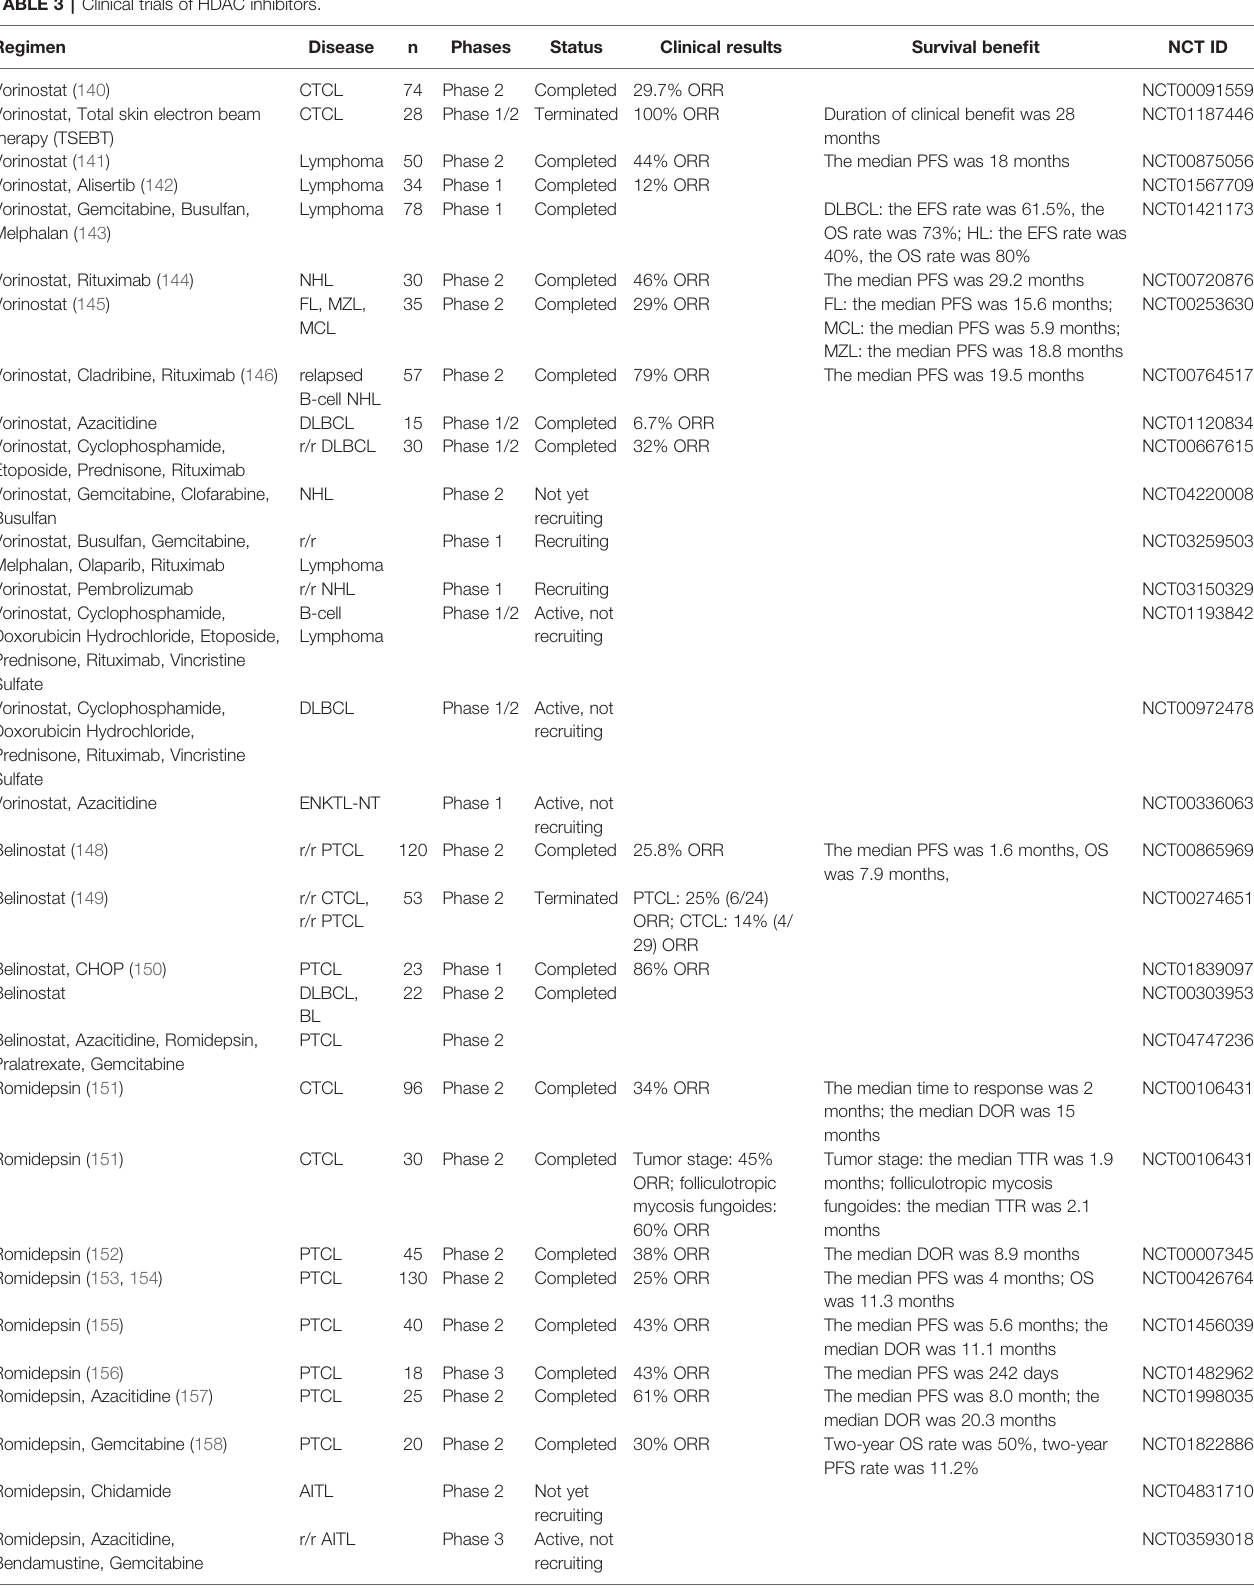
TABLE 3 | Clinical trials of HDAC